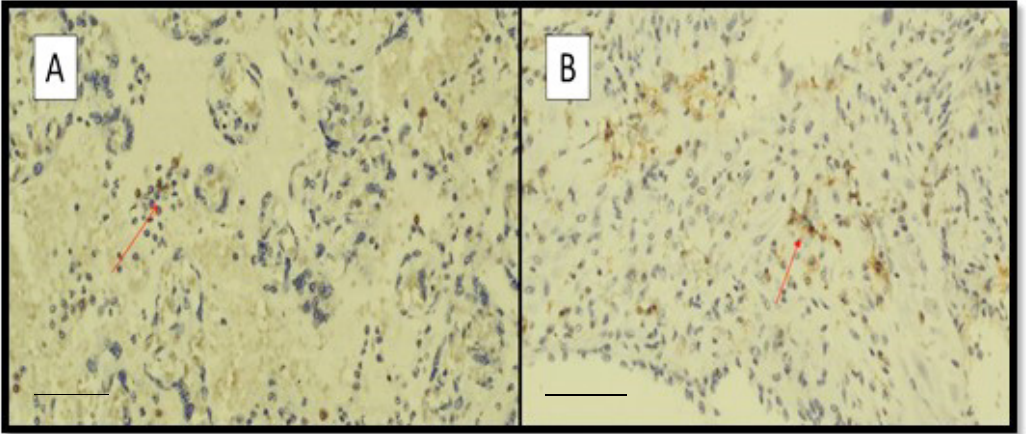
Figure 2. Examples of the presence of CD4 + T lymphocytes in intervillous space ( A ) and basal plate ( B ) from a mother belonging to CIC group. Note that, in our analysis, there was no statistically significant difference ( p > 0.05) between the three groups. (Immunohistochemistry for CD4, Original Magnification 20×, red arrows indicate CD4 positive lymphocytes, scale bar: 350 µm).